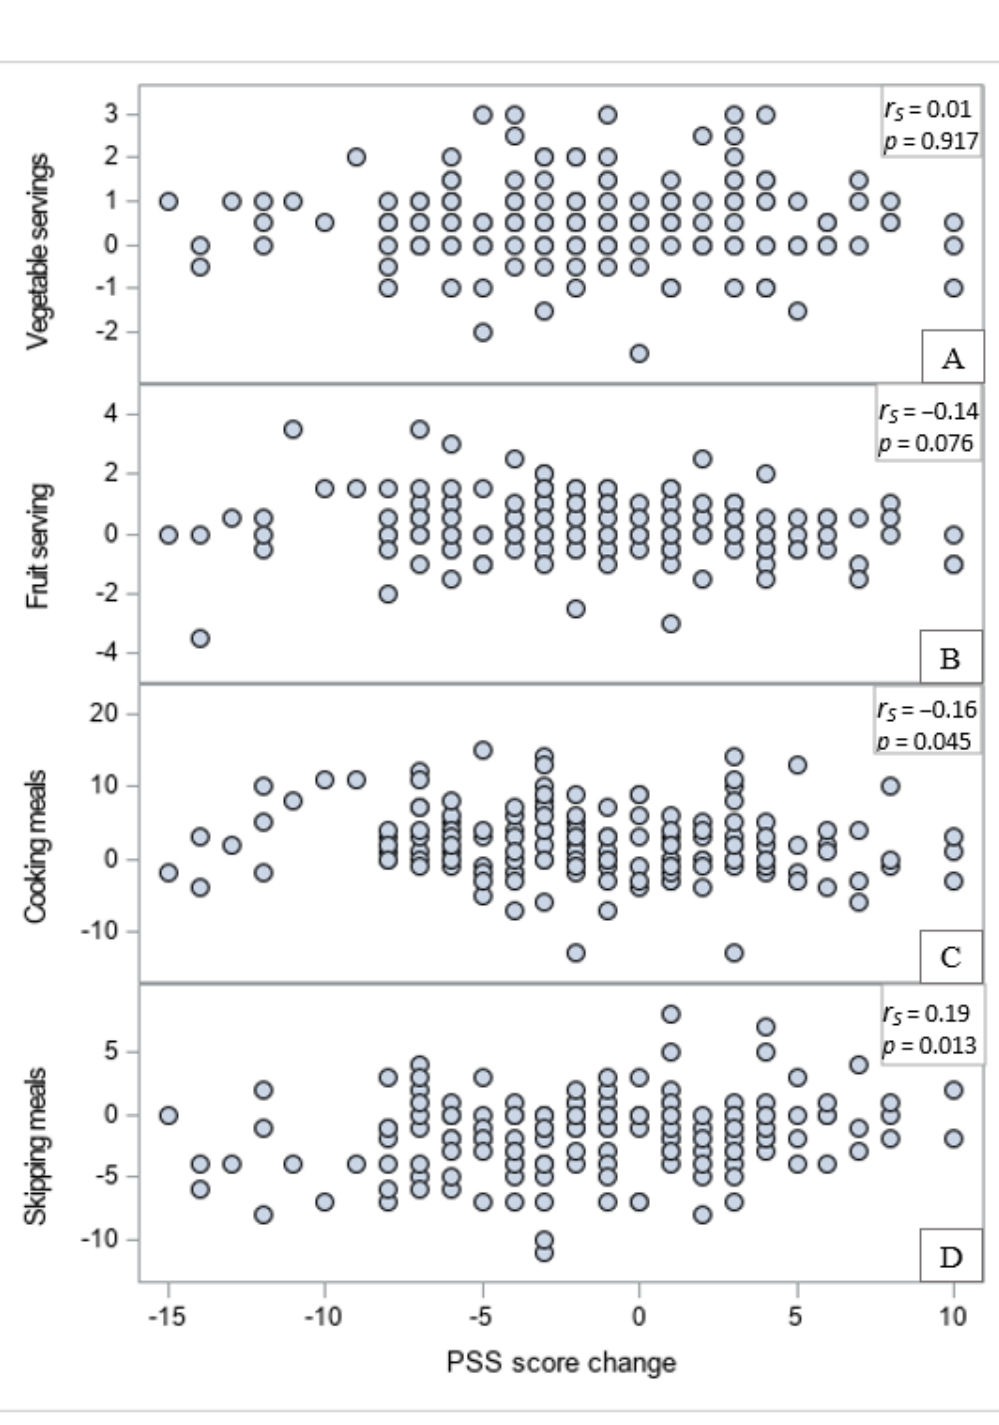
Figure 3. Scatter plots and Spearman correlations ( r S and p -values) between previously reported changes in vegetable (A), fruit intake (B), cooking frequency (C), skipping meals frequency (D) and changes in the Perceived Stress Scale (PSS) scores ( n = 163).